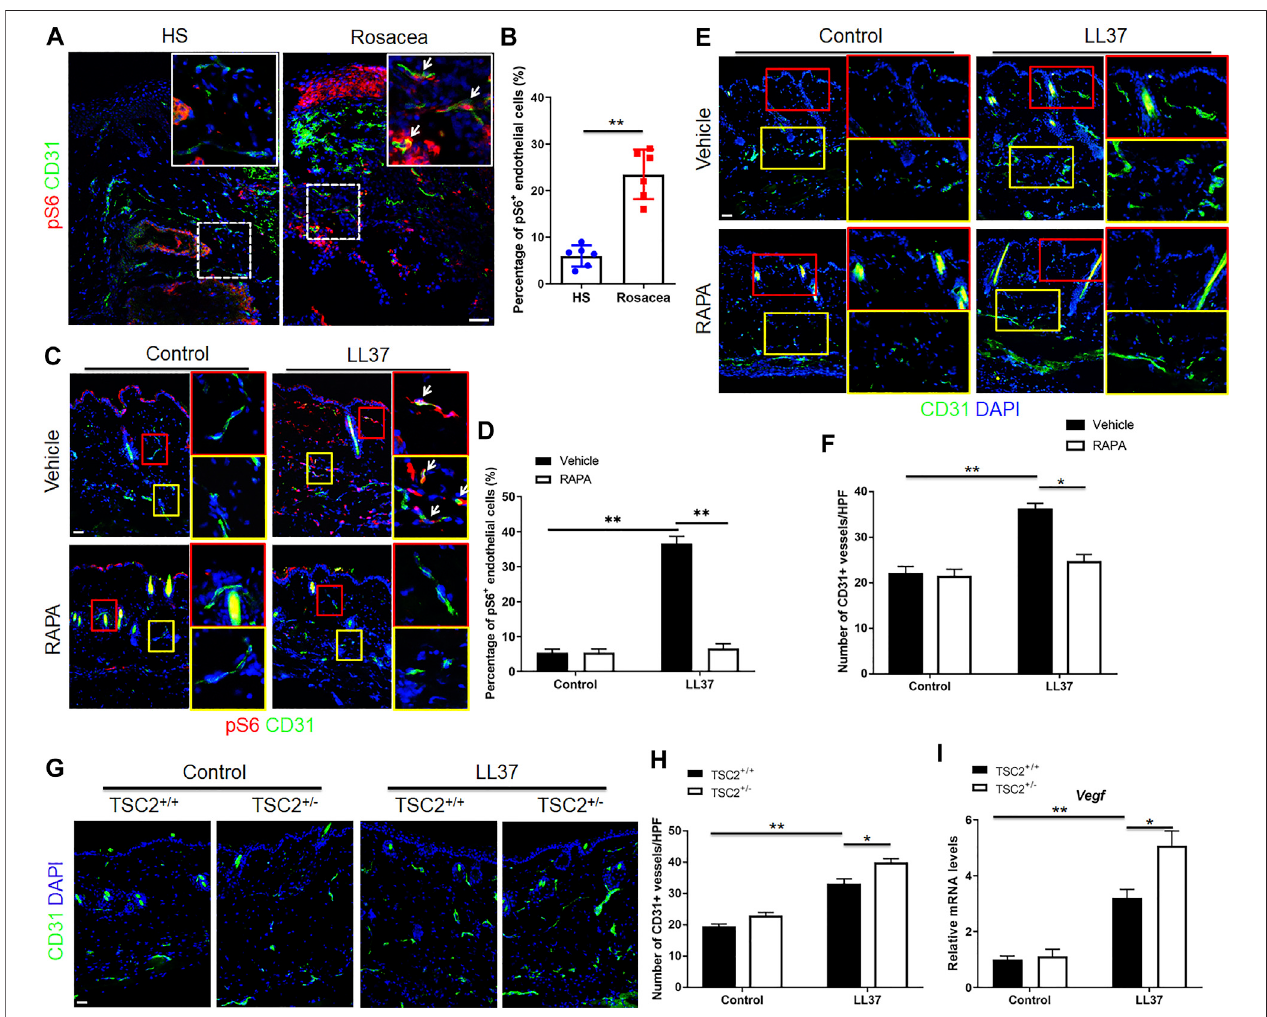
FIGURE 3 | mTORC1 signaling regulates LL37-induced cutaneous angiogenesis in vivo . (A,B) Immunostaining of pS6 and CD31 (A) , and quantitative analysis of pS6 and CD31 double positive cells (indicated by white arrows) (B) in skin tissues from healthy skin and rosacea patients. (C,D) Immunostaining of pS6 and CD31, and quantitation of pS6 and CD31 double positive cells (indicated by white arrows) in mice skin tissues treated with LL37 and/or RAPA. (E,F) Immunostaining of CD31, and quantitativeanalysisofthenumberofCD31 + vesselsincontrolandLL37-treatedrosacea-likemousemodeltreatedwithorwithoutRAPA. (G,H) Immunostainingof CD31,andquantitationofCD31 + vesselsinWTandTSC2 +/ − mouseskintreatedwithorwithoutLL37. (I) Vegf mRNAexpressioninWTandTSC2 +/ − mouseskintreated withor withoutLL37 byRT-qPCR. (A,C,E) Rightpanelsindicatethemagni fi edpicture intheleftboxwiththesamecolor. Scalebar:50 μ m. Datarepresent mean ± SEM from three independent experiments. Two-tailed unpaired Student ’ s t-test (B) or 1-way ANOVA with Bonferroni ’ s post hoc test (D,F,H,I) was used * p < 0.05 and ** p <